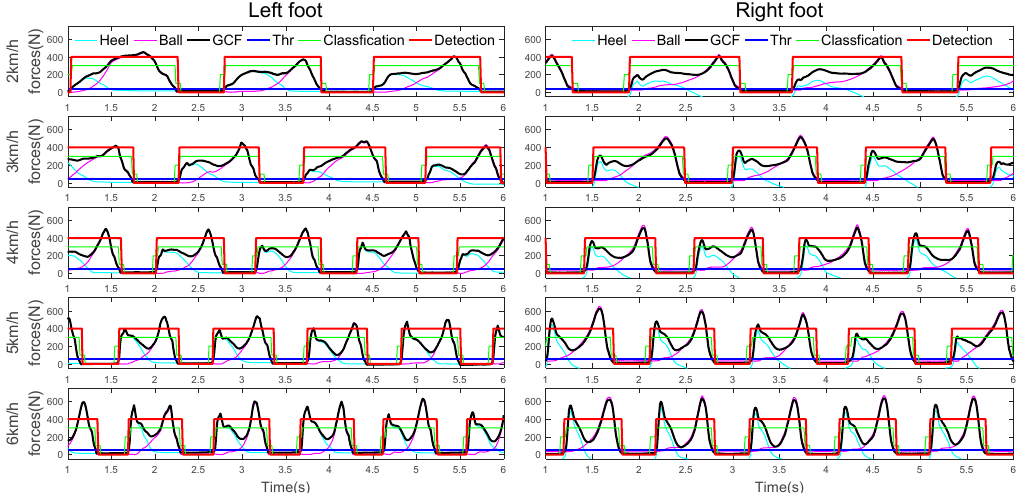
Figure 10. A subject gait phrase detection at speeds of 2~6 km/h.